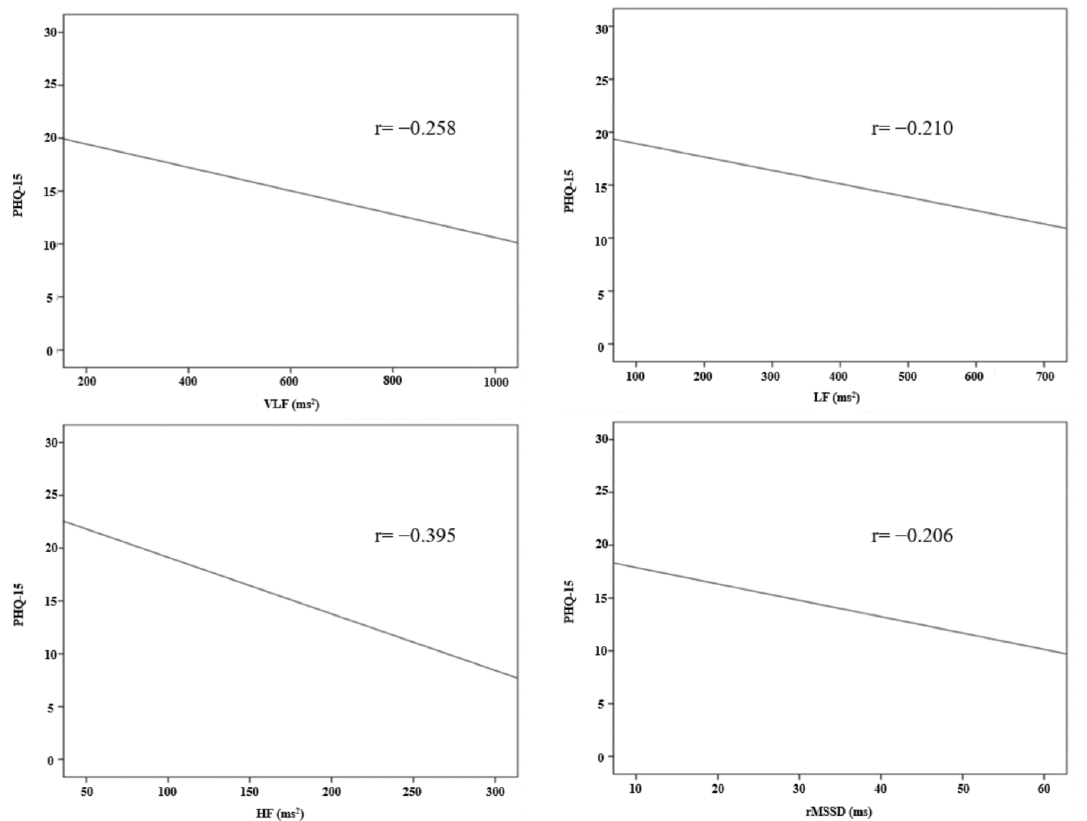
Figure 2. Correlation between HRV parameters and PHQ-15.